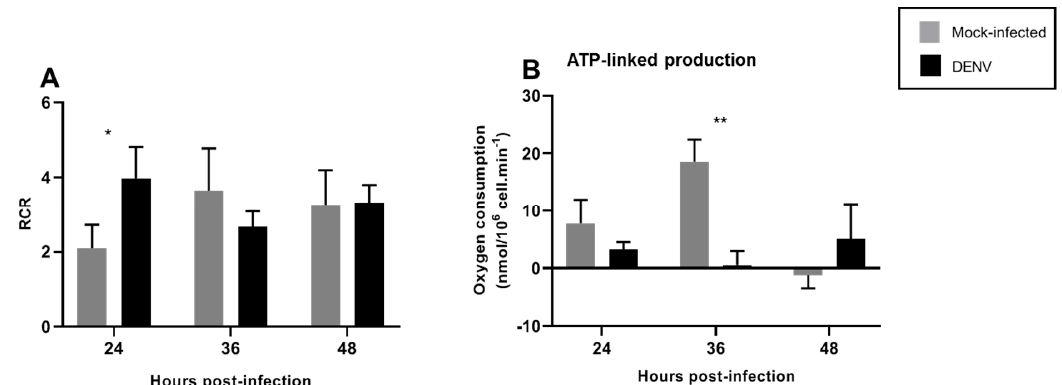
Figure 6. DENV2-induced changes in mitochondrial respiration in the C6/36 cell line. C6/36 cells were infected with DENV2 at MOI 5 and incubated for different periods of time; 24, 36, and 48 hpi. ( A ) The RCR (respiratory control ratio) represents the mitochondrial coupling state. ( B ) The ATP-linked production is the respiration contributing to ATP generation and was obtained by subtracting proton leak respiration from basal respiration. Data are shown as mean ± SD from three independent experiments. Statistical analyses were performed by two-way ANOVA and Sidak ´ s multiple comparison test. p < 0.05 (*), p < 0.001 (**). DENV: dengue virus.